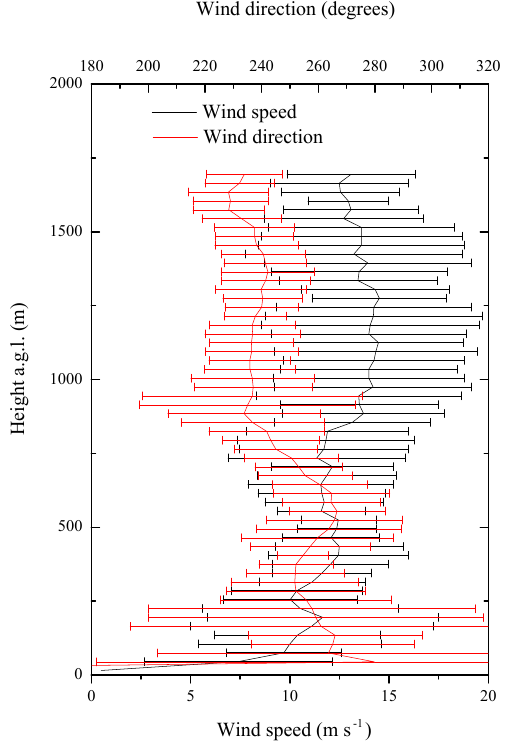
Figure 4. Vertical profile of wind speed and direction averaged over the time interval 12:00–13:00UTC on 18 April 2013, as measured by the wind lidar located in the proximity of BASIL at the Super- site JOYCE. Profiles are reported with error bars, corresponding to ± 1 standard